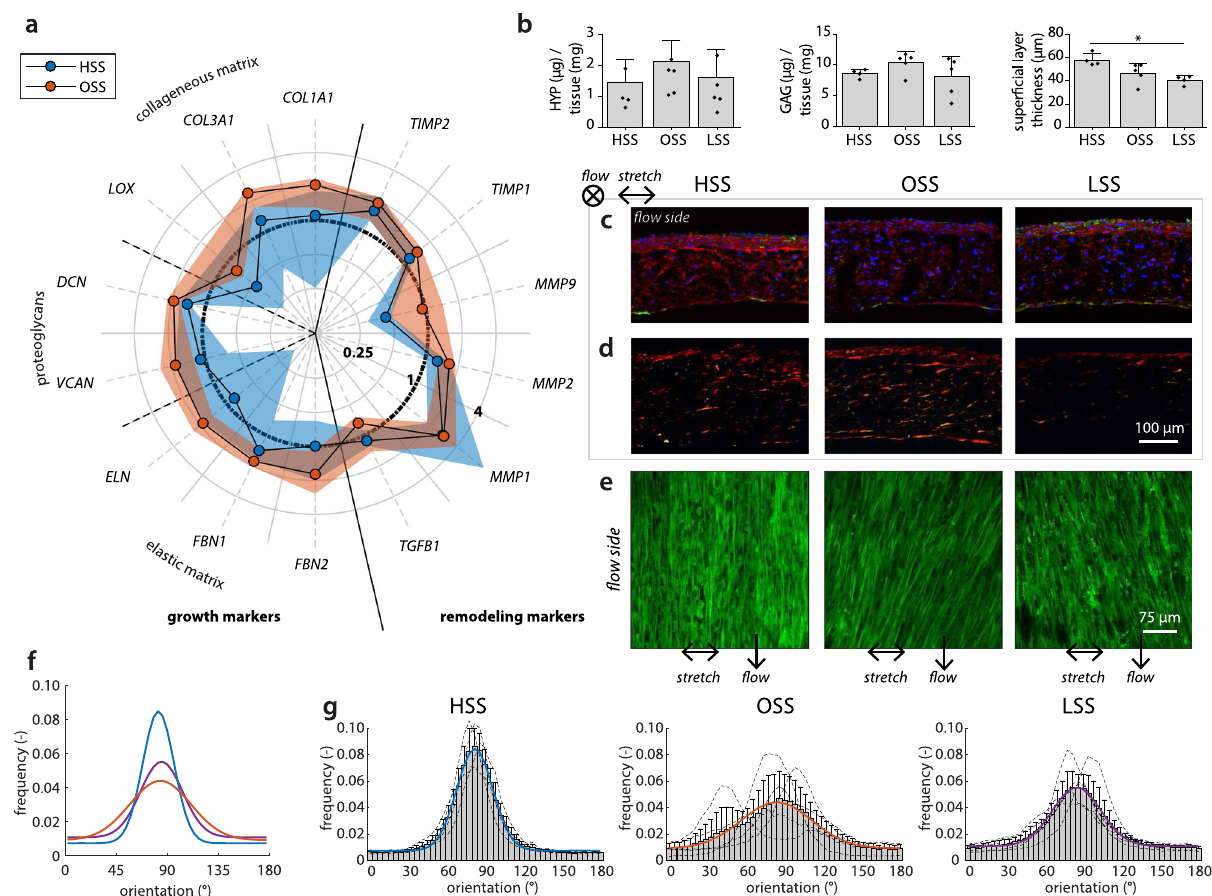
Fig. 6 Changes to matrix growth, remodeling, and organization in response to shear stress. a Relative gene expression compared to the low shear stress condition (indicated by the circle at 1) for markers related to growth (i.e., collageneous matrix, proteoglycan, and elastic matrix formation), as well as markers related to remodeling. The dots and shaded areas indicate, respectively, the 50th and 25th – 75th percentiles. See Supplementary Fig. S1 for all boxplots of the gene expression data. b Total hydroxyproline (left) and glycosaminoglycan (middle) content normalized to total construct mass, and quanti fi cation of the thickness of the appositional collagen layer on top of the scaffold from the confocal z -stacks in e (right, * p < 0.05). Representative sections of each experimental group stained for ( c ) α SMA (green), collagen I (red), and DAPI (blue) and ( d ) Picrosirius red (visualized under polarized light). e Confocal visualization of the collagen structure. f Overlay plot and g separate histograms quantifying the angular collagen distribution in the appositional matrix layer for each condition (directions of applied shear stress (90°) and stretch (0°) indicated by the arrows in c – e . Bars represent mean ± standard deviation. HSS high shear stress condition (3.2 Pa, n = 4), OSS oscillatory shear stress condition (±3.2 Pa, n = 5), LSS low shear stress condition (0.4 Pa, n = 4 or